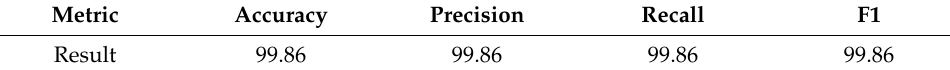
Figure 4. Subject ‐ wise results of the proposed LBP ‐ NCA ‐ based coronary angiography print method.